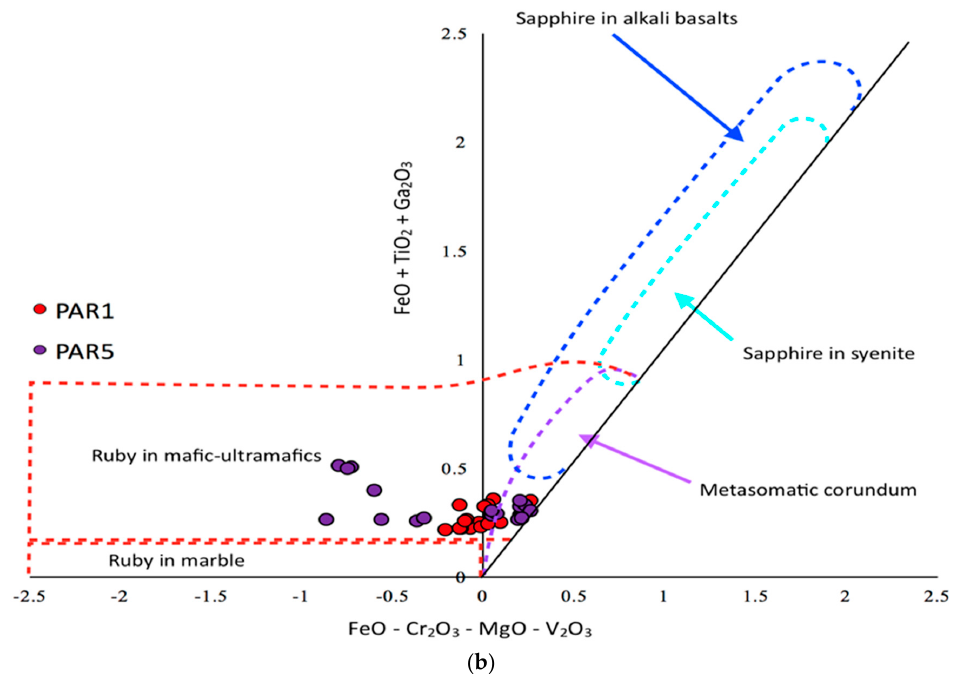
Figure 3. Trace element discrimination diagrams showing the fields for magmatic, metamorphic and metasomatic corundums, along with the plots for the Paranesti rubies. ( a ) FeMg vs. GaMg elemental diagram showing the metamorphic vs magmatic fields and SD lines with Paranesti ruby plots. Adapted with permission from Sutherland et al. 2014 [19]. ( b ) FeO + TiO 2 + Ga 2 O 3 vs. FeO-Cr 2 O 3 -MgO-V 2 O 3 diagram showing the metamorphic vs magmatic fields and SD lines with Paranesti ruby